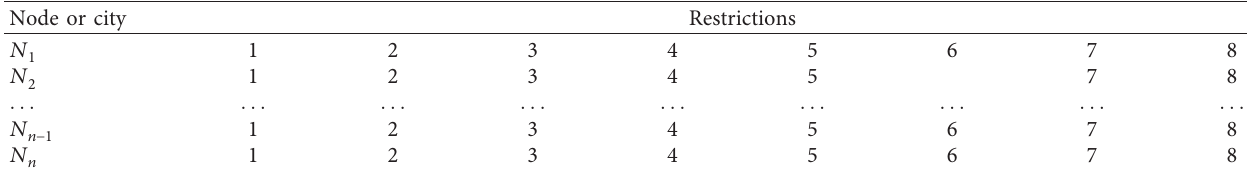
Table 2: LPH list.